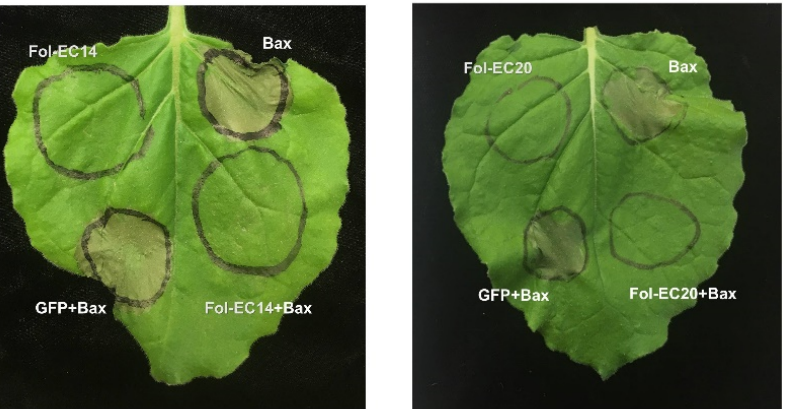
Figure 5. Fol-EC14 and Fol-EC20 can suppress Bax -induced cell death. A. tumefaciens carrying either Fol-EC14 or Fol-EC20 effector candidate gene was infiltrated into N. benthamiana leaves, followed 24 h later by infiltration with A. tumefaciens carrying the Bax gene. GFP served as a negative control. Representative leaves were photographed 3 days after infiltration and the experiment was repeated at least three times with consistent results.